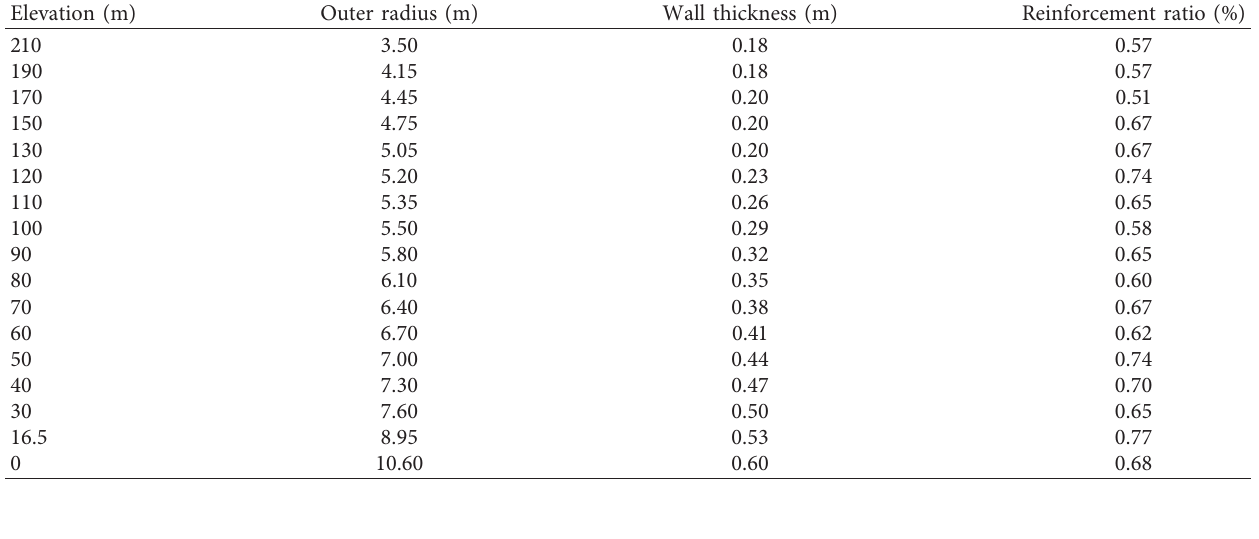
Table 3: Parameters of 210m high RC